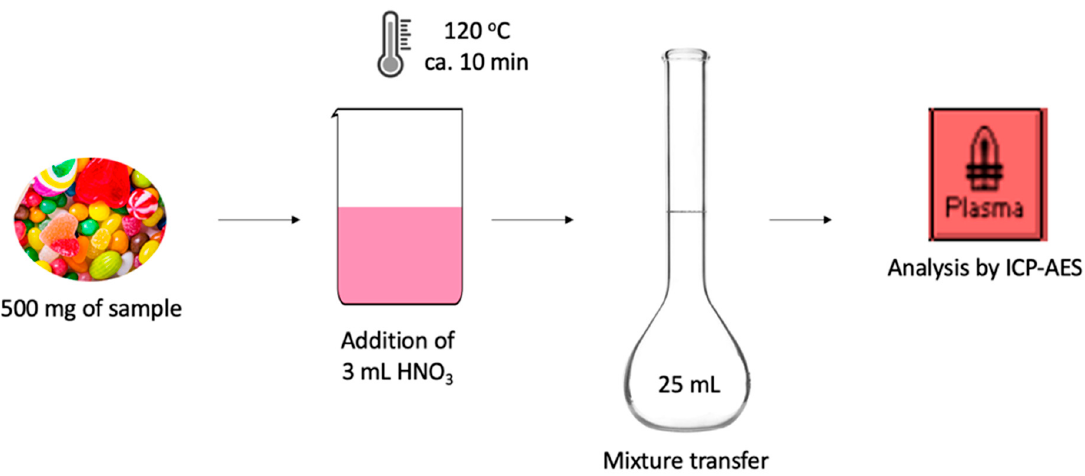
Figure 1. Schematic representation of the experimental procedure.